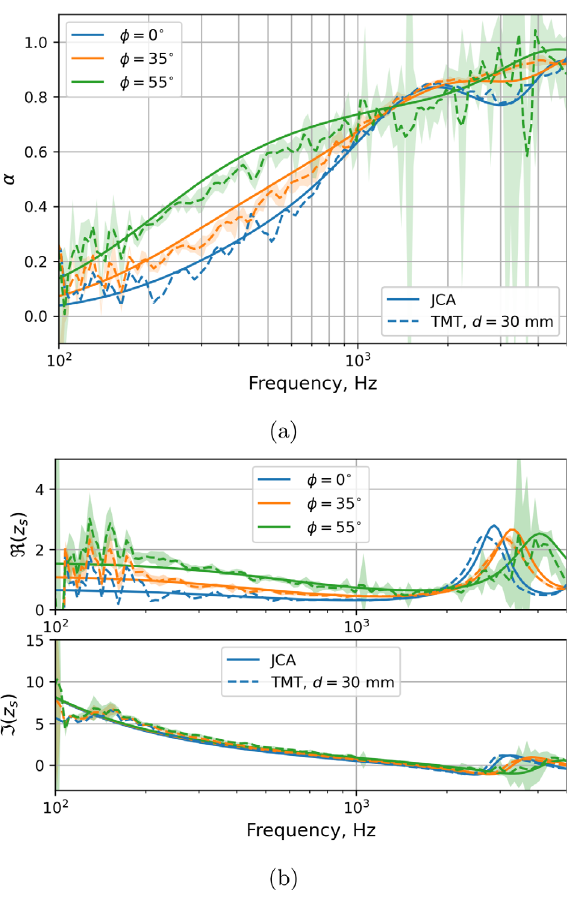
Figure 17. Absorption coef fi cient a (a) and normalized surface impedance z s (b) for the system shown in Figure 16 for different incidence angles with a = 100 cm, b = 20 cm, D m (cid:7) 2 cm, k = 10 (cid:3) 7 , z a = 0.5 cm.